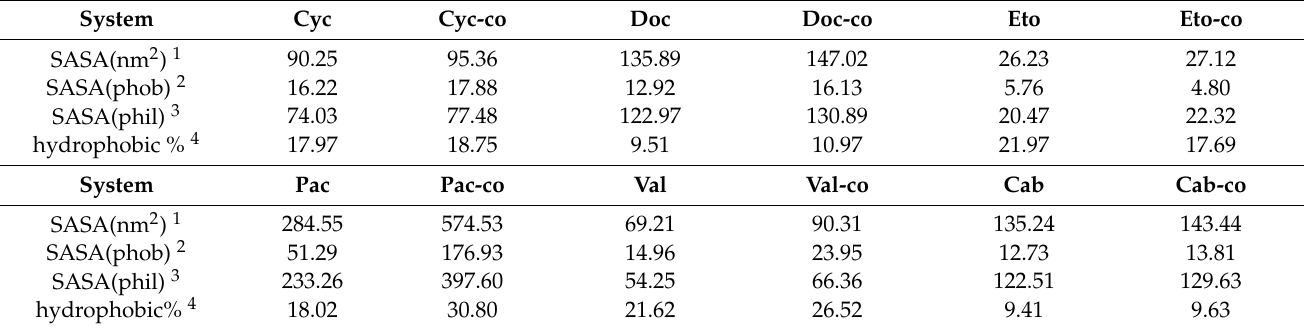
Figure 10. The hydrophilic (green) and hydrophobic (orange) chains of ( a ) Polyoxyl 35 castor oil and ( b ) Polysorbate 80. Table 4. The R g and SASA values of systems without cosolvents and with